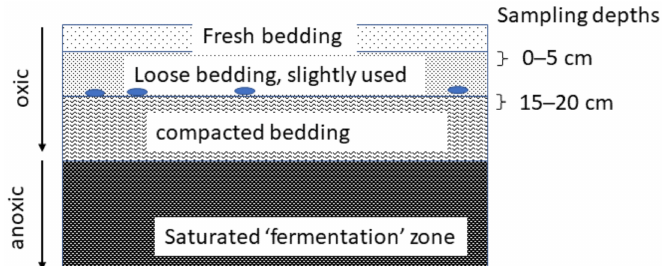
Figure 1. Vertical stratification of compost bedded pack. Loose fresh bedding was removed and two layers of oxic conditions were sampled. The upper (0–5 cm) layer was a relatively dry zone with slightly used, loose bedding. The second layer (15–20 cm) layer was compacted and thermophilic. Temperature and oxygen measurements (ovals) were taken at the interface between two oxic layers, not the saturated ‘fermentation’